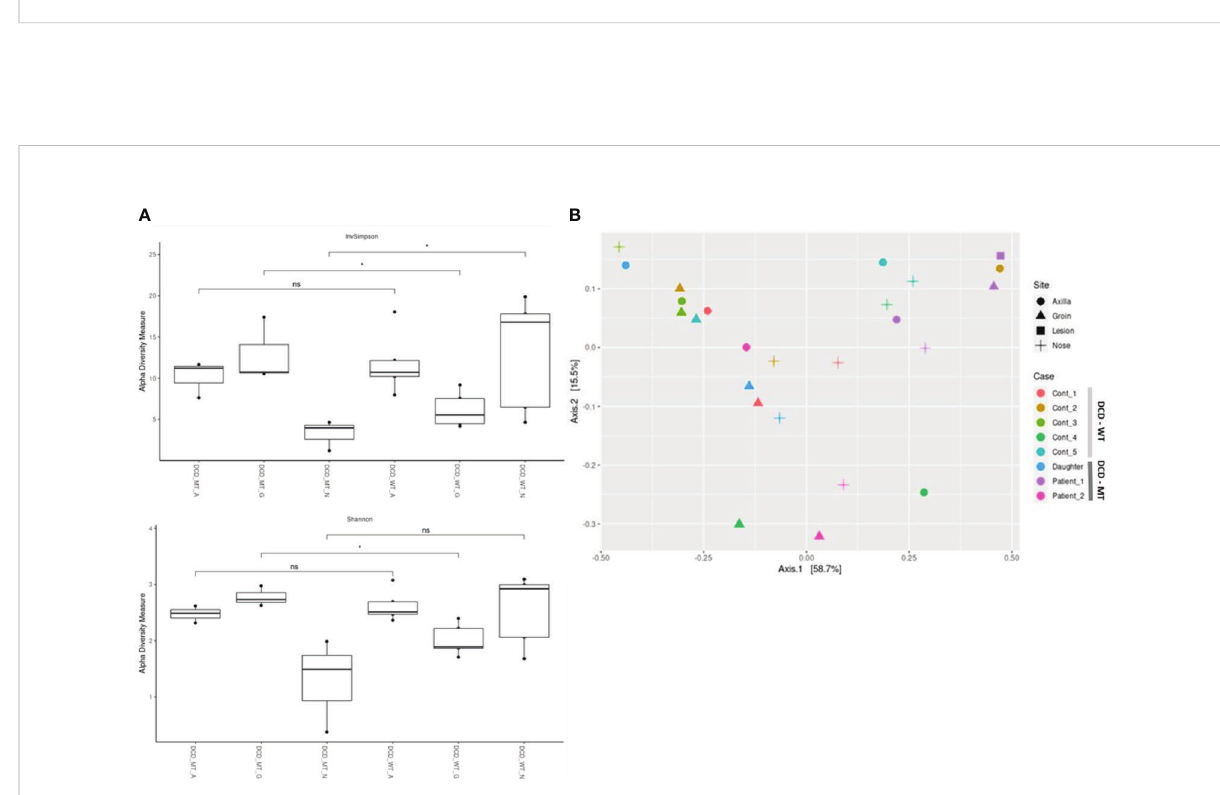
FIGURE 8 Characterization of microbial diversity in study population (DCD-MT) versus healthy controls (DCD-WT) in three anatomical sites (A) alpha diversity expressed in InvSimpson and Shannon measures and compared statistically using Wilcoxon signed-rank test (B) Beta diversity expressed in Weighted UniFrac measure and Principal Coordinate Analysis (PCoA). (ns: non signi fi cant;